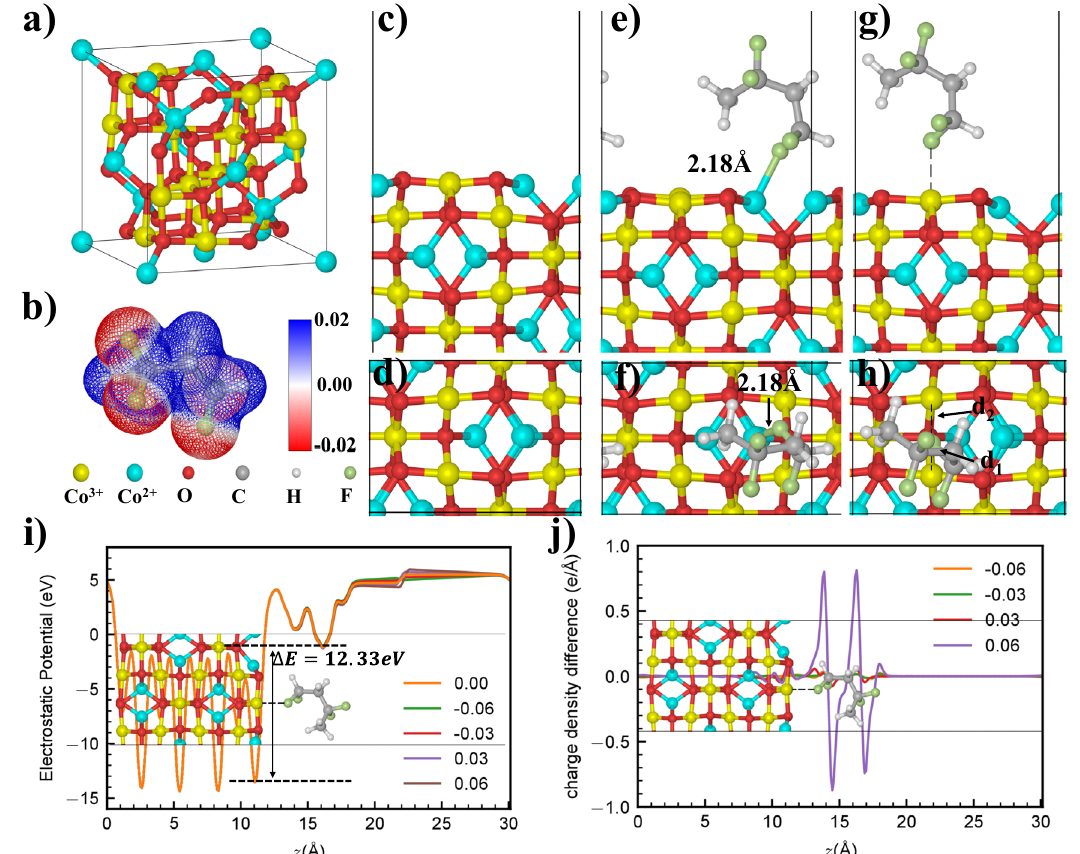
Fig. 3 | Density functional theory (DFT) study on the molecule adsorption on Co3O4(110) surface taking the electric fi led into consideration. a The bulk structure of Co 3 O 4 . It contains Co 2+ and Co 3+ . b The electrostatic potential surface (ESP)ofthemolecule. c , d sideandtopviewoftheCo 3 O 4 (110)surfacewiththeCo 3+ , Co 2+ and O atoms exposure. e , f Side and top view of the molecule adsorption on Co 2+ site. g , h Side and top view of the molecule adsorption on the Co 3+ site. i The electrostaticpotentialalong z -axisatelectric fi eld0.00eV/Åwithvalue Δ E12.33eV.